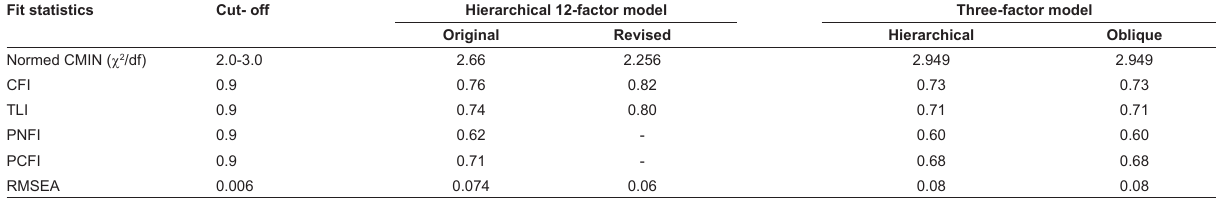
Table 5 Fit indices for the comparative models of the organisational climate questionnaire